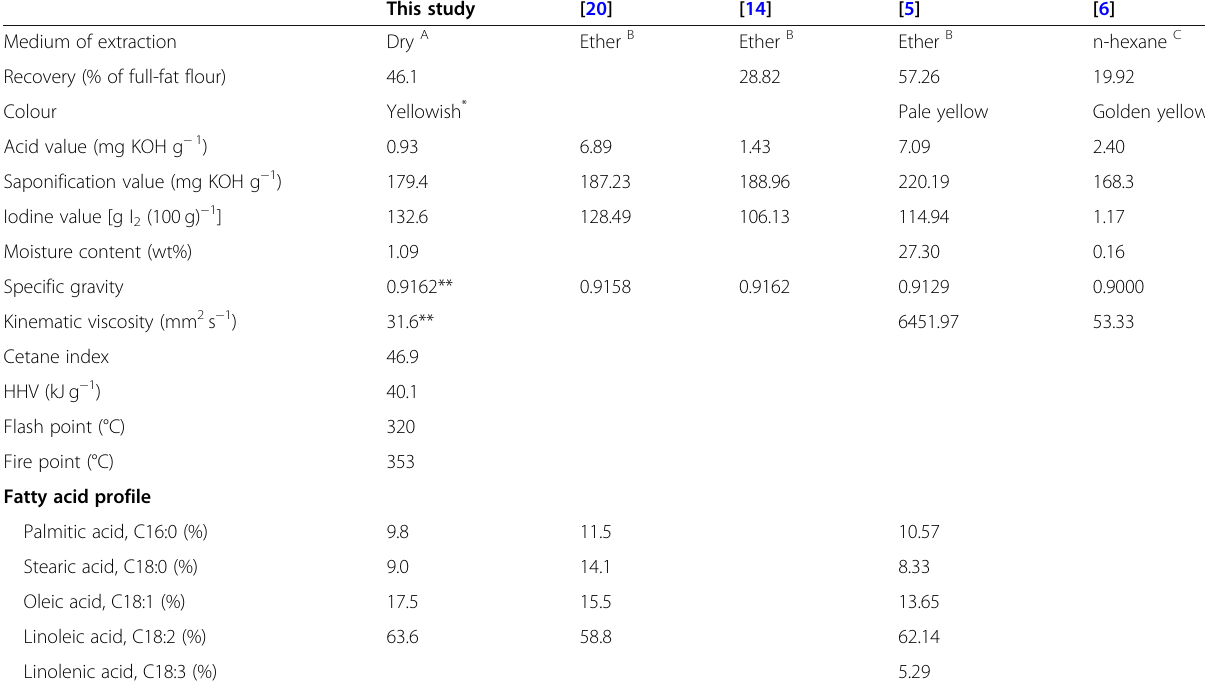
Table 1 Physicochemical properties of